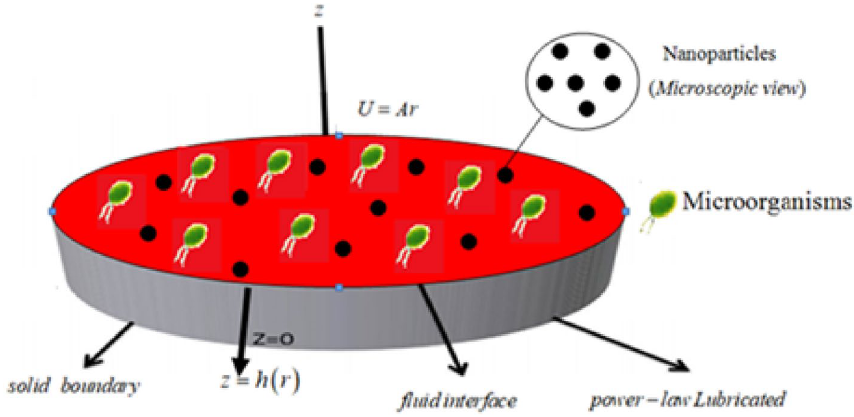
Figure 1. Schematic flow and coordinates